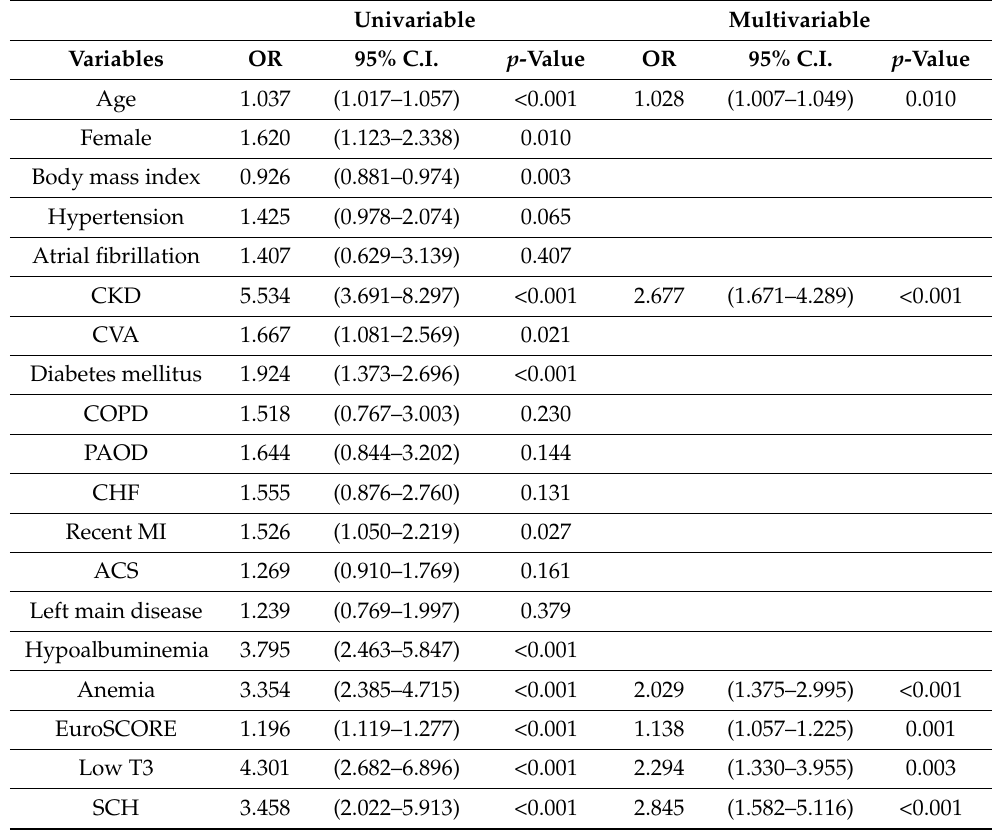
Table 4. Logistic regression analyses of risk factors for the composite